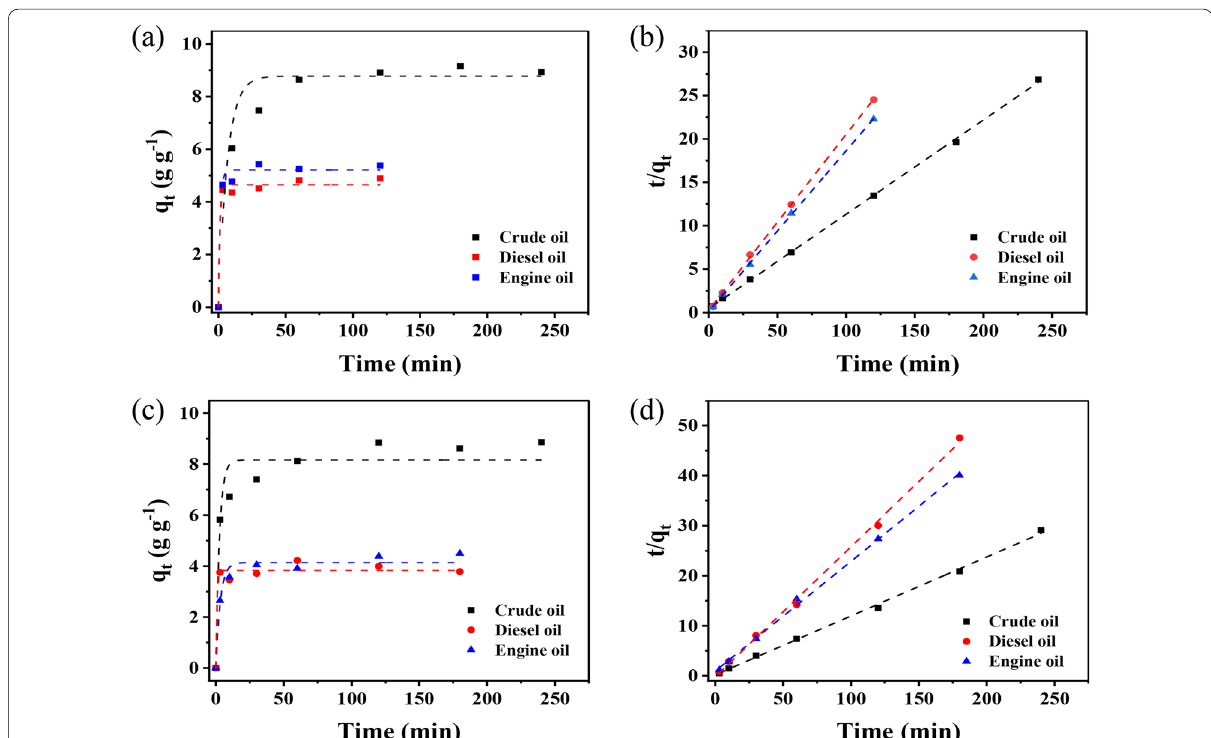
Fig. 7 The pseudo-first-order kinetics model of oils sorption on CSBC (350 ℃ ) ( a ) and OMBC ( c ). The pseudo-second-order kinetics model of oil sorption on CSBC (350 ℃ ) ( b ) and OMBC ( d